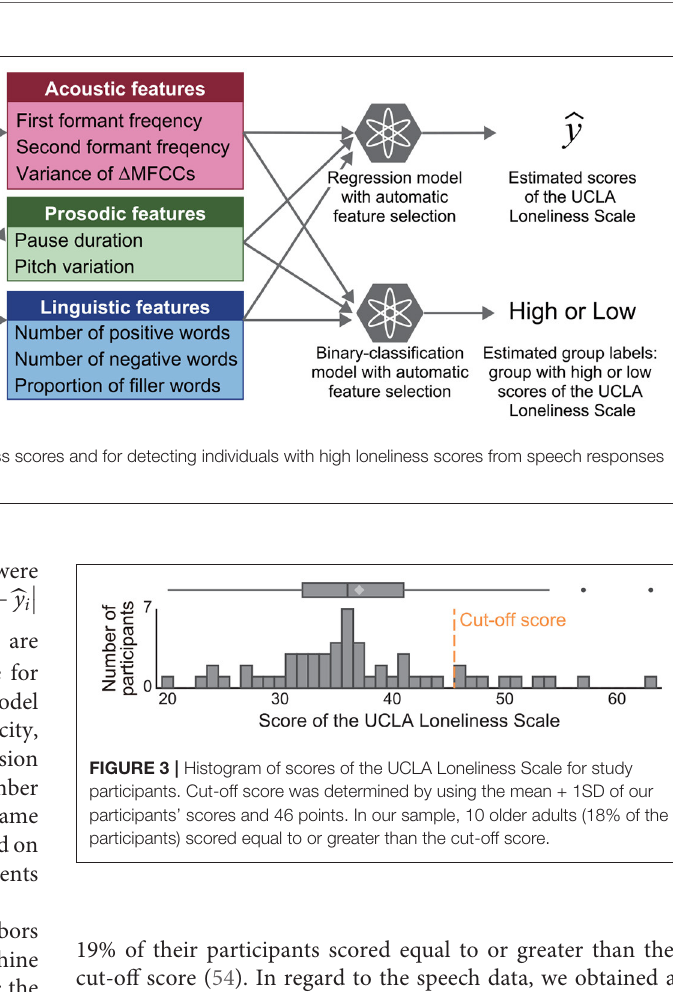
FIGURE 3 | Histogram of scores of the UCLA Loneliness Scale for study participants. Cut-off score was determined by using the mean + 1SD of our participants’ scores and 46 points. In our sample, 10 older adults (18% of the participants) scored equal to or greater than the cut-off